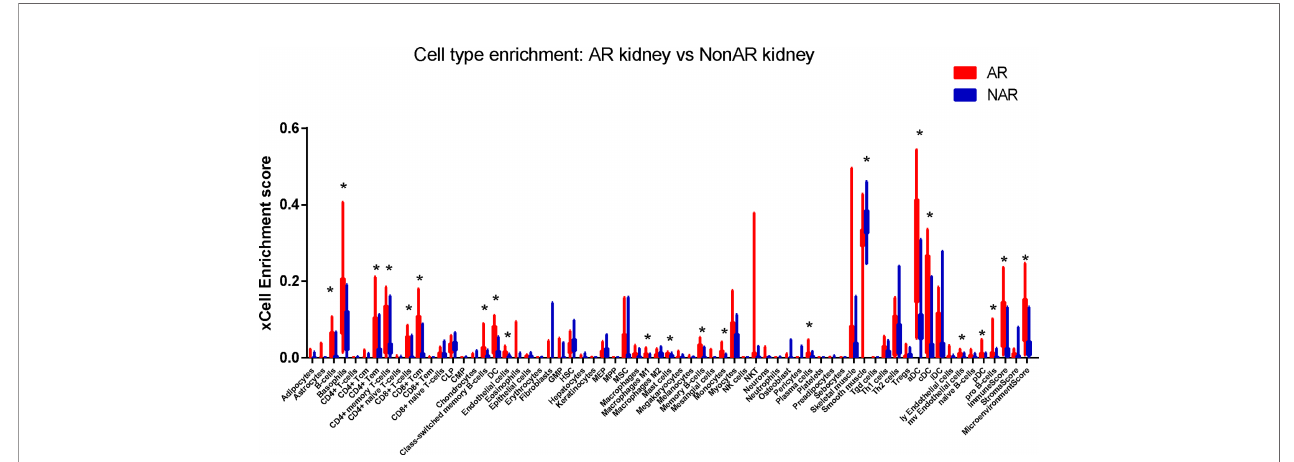
FIGURE 6 | Immune cells enrichment. Distribution of cell-type enrichment scores for AR and NAR. xCell, a bioinformatics tool, was used to provide an enrichment score for different cell types that allow comparison of cell types across group. The x-axis represents cell types. The y-axis represents the xCell enrichment score. * p <